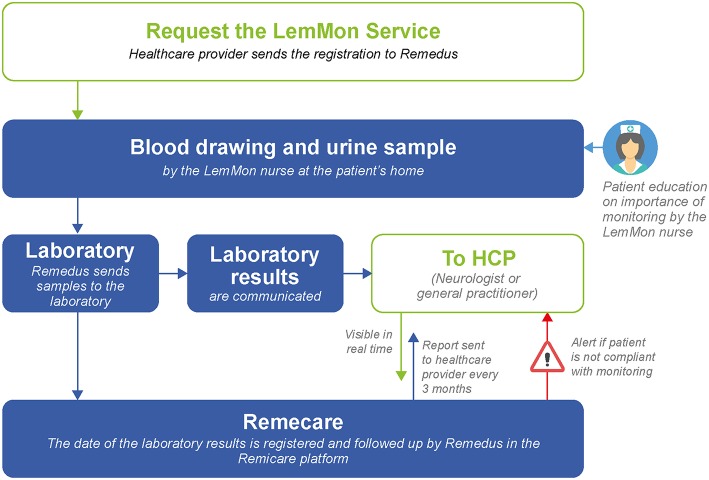
The Remedus data management platform.